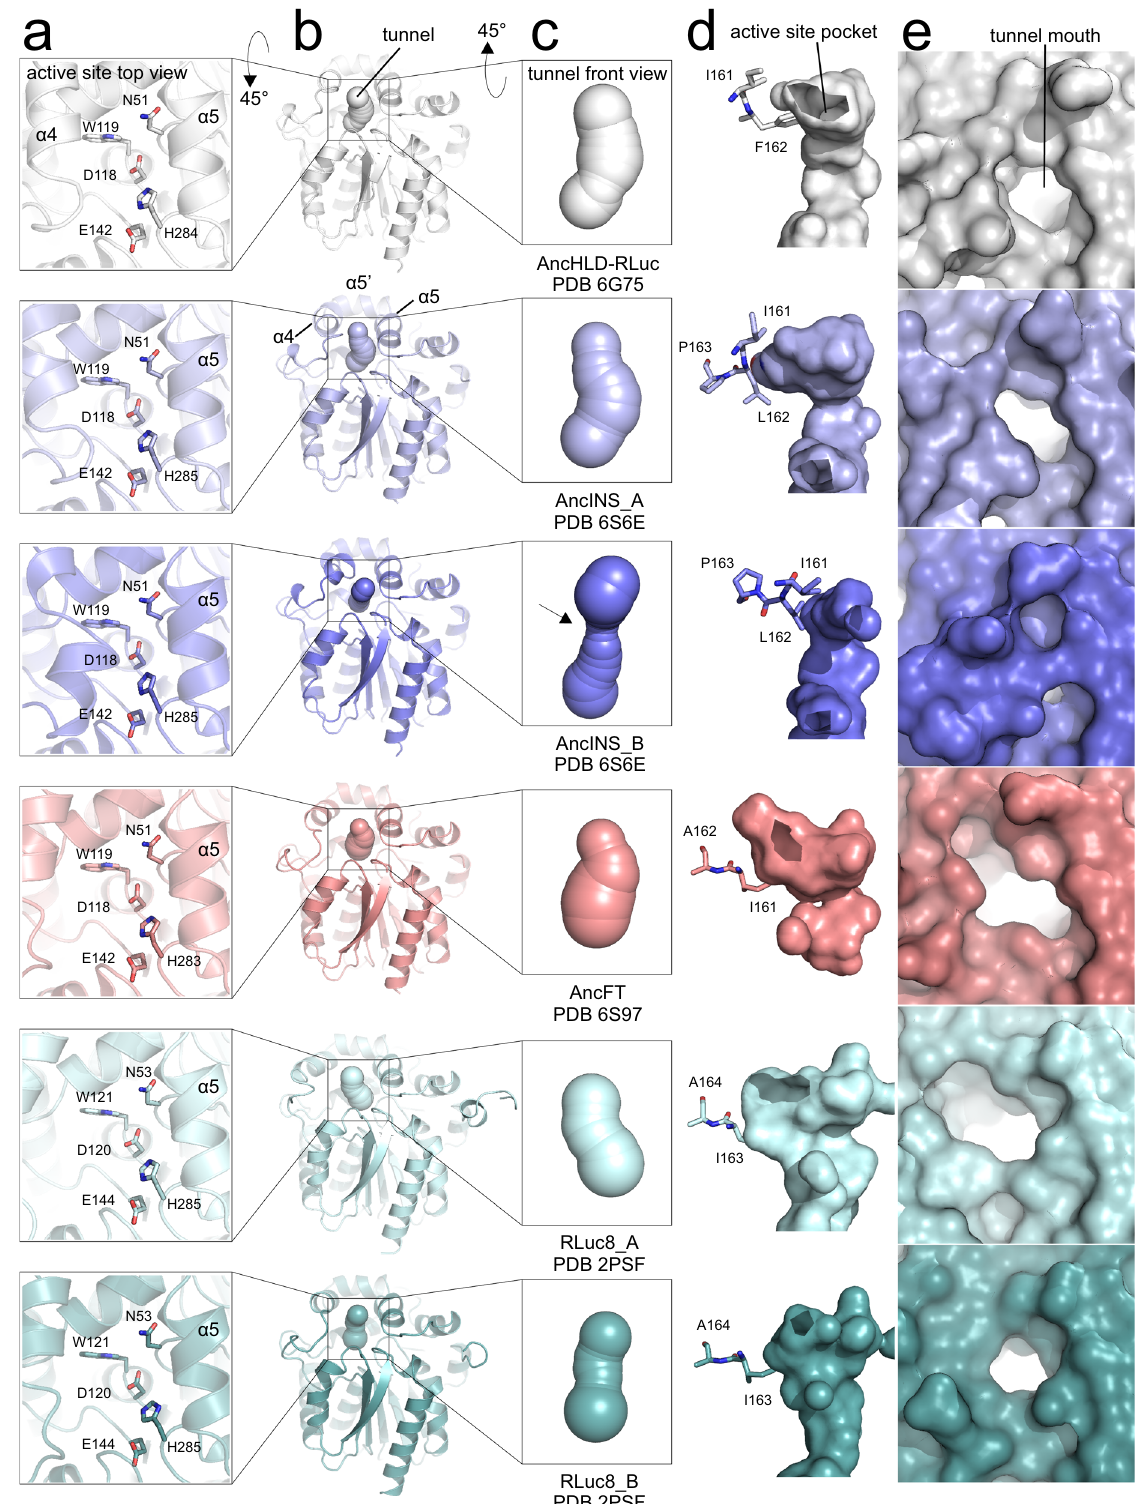
Fig. 4 Comparison of structural changes in the apo forms of the enzymes. Anc HLD-RLuc (white), AncINS (chain A light blue, chain B slate), AncFT (salmon), RLuc8 (chain A pale cyan, chain B light teal). a Top view of the active site. The putative catalytic pentad and α 5 helix occupy the same position in all proteins, but the α 4 helix adopts different conformations. b Crystal structure of the whole protein, with the main access tunnel (identi fi ed using Caver 3.02 23 ) shown as spheres. The outward/inward movement of the α 4 helix causes opening/closing of the tunnel. c Front view of the main tunnel. The black arrow indicates the visible constriction due to closure of the α 4 helix. d The size of the active site cavity is changed by repositioning of amino acids in the α 4 helix. e The size of the main tunnel mouth is changed by movements of the α 4 helix and L9